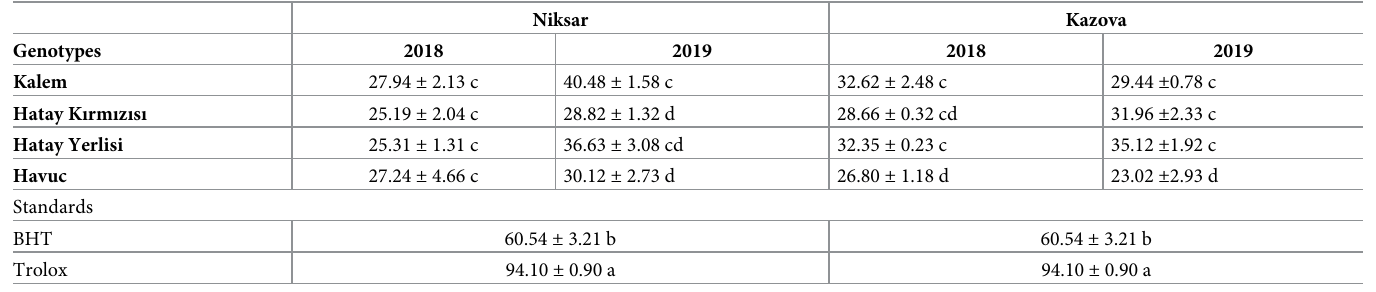
Table 6. The DPPH scavenging activity of local sweet potato genotypes used in the current